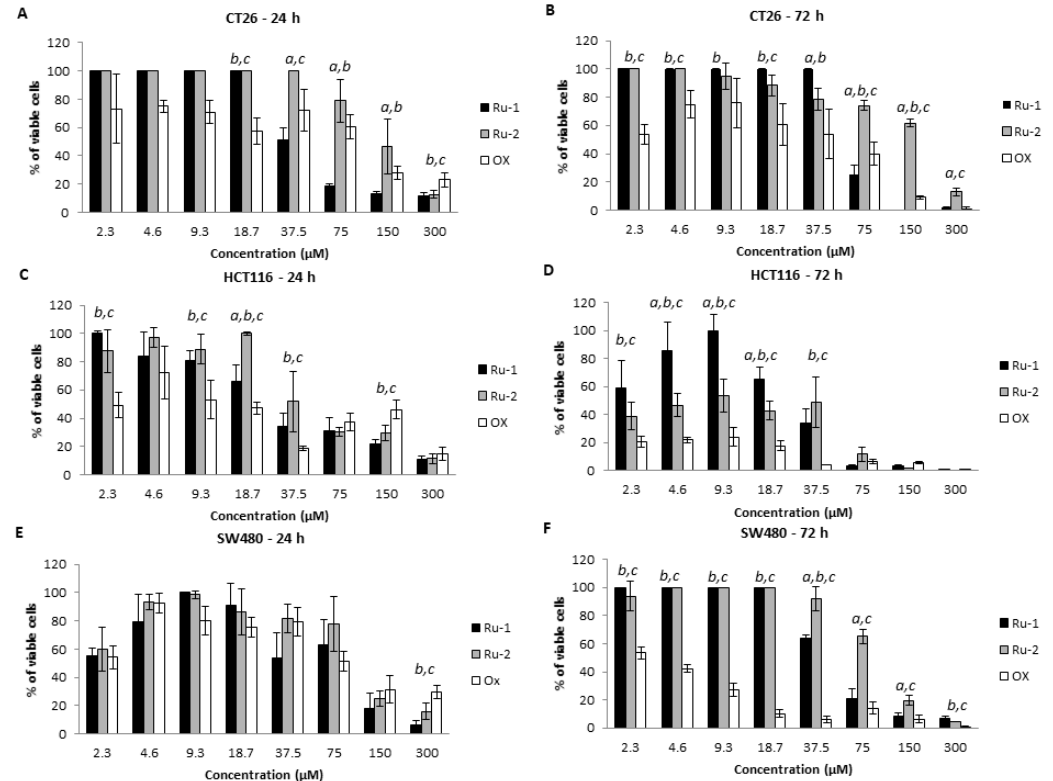
Figure 4. Dose and time-dependent cytotoxicity of ruthenium(II) terpyridine complexes against human and murine colon carcinoma cells. Effect of ruthenium(II) complexes and oxaliplatin on viability of ( A , B ) CT26 cells; ( C , D ) HCT116 cells; ( E , F ) SW480 cells after 24 h and 72 h analyzed by the MTT assay. All data are presented as mean values ± SD from three independent experiments performed in triplicates. p < 0.05, a— Ru-1 vs. Ru-2 ; b— Ru-1 vs. Ox ; c— Ru-2 vs. Ox .